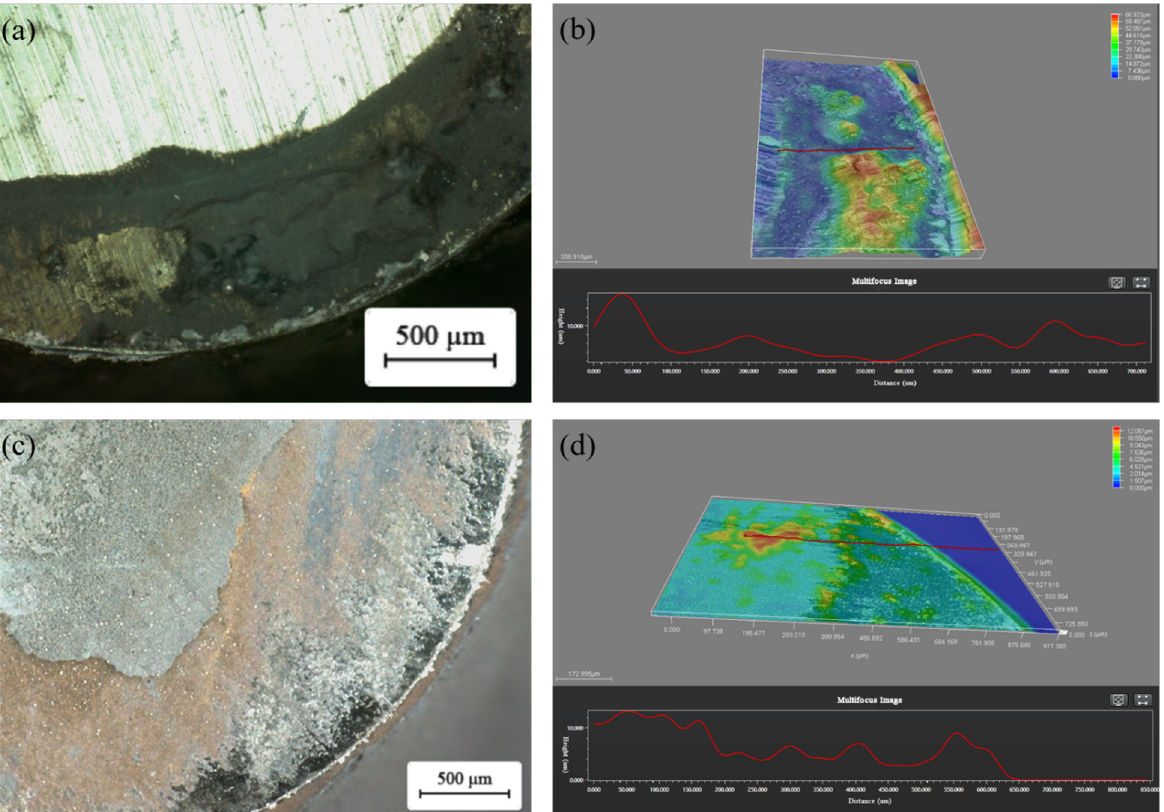
Figure 15. The surfaces of uncoated (YG8)/coated (YG8-10) carbide round rods after friction at 100 N pressure. ( a ) A large number of built-up edges are formed at the edge of the friction surface of the uncoated carbide round rod; ( b ) the friction surface; ( c ) a small amount of built-up edges are formed on the friction surface of the coated carbide round rod; ( d ) the friction surface fluctuation.